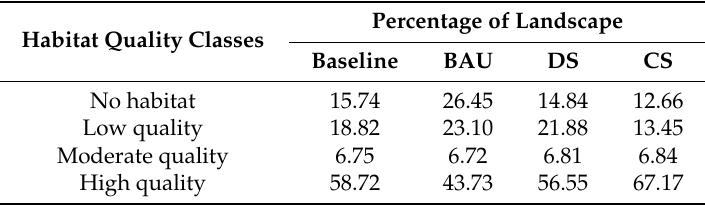
Table 3. Habitat quality classes under the LULC scenarios. Habitat Quality Classes